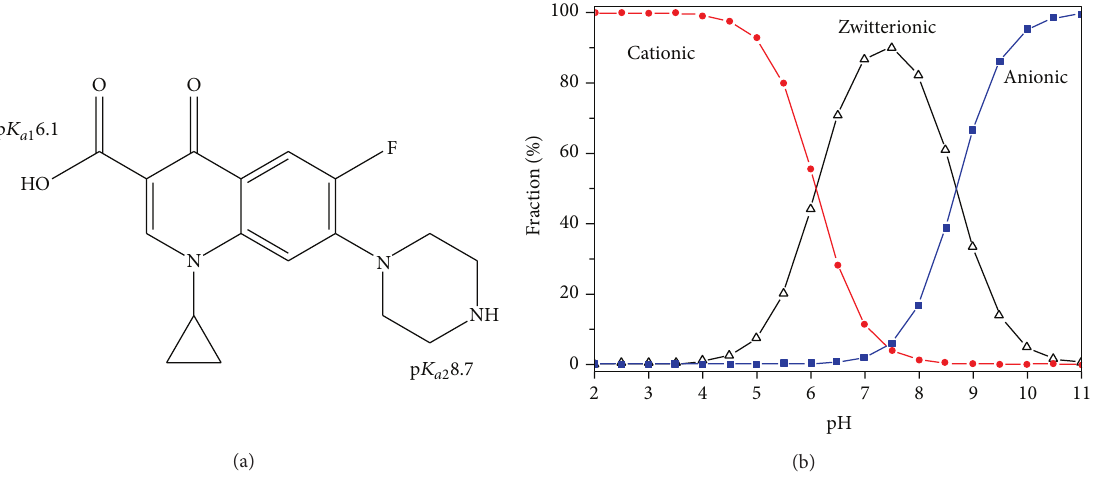
Figure 1: Molecular structure of ciprofloxacin (a) and speciation of CIP as a function of solution pH (b).